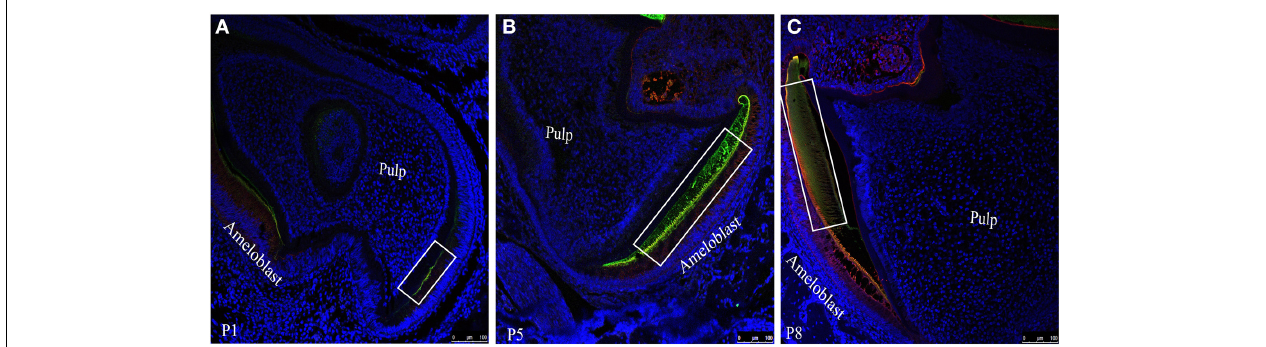
Figure 5A . We have divided this co-localization region (yellow colored) into 14 small regions of interest (ROIs) and the direc- tion of analyzed region of interest in Figure 5 is indicated by pink arrow along the secretory face of the ameloblast (at the enamel surface) from the cervical loop to tip of the molar. Then Mander’s co-localization coefficients were calculated to charac- terize the degree of overlap between two channels ( Figure 5B , green for Amgn and Figure 5C , red for Ambn) in the image and to predict the contribution of each particular antigen to the